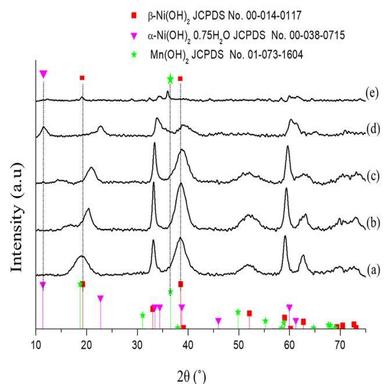
Diffractograms of (a) Ni(OH)2, (b) Ni0.95Mn0.05(OH)2, (c) Ni0.9Mn0.1(- OH)2, (d) Ni0.75Mn0.25(OH)2 and (e) Ni0.5Mn0.5(OH)2.